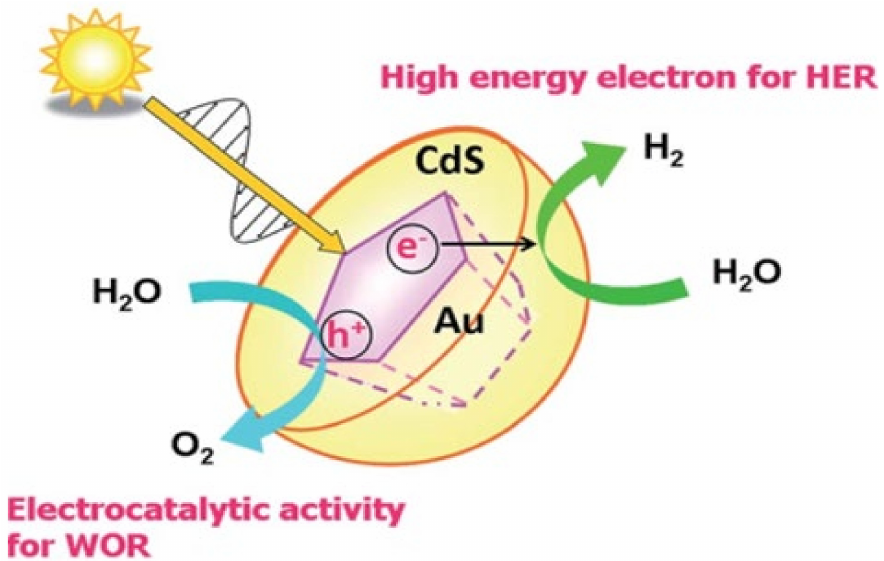
Figure 57. Schematic representation of water splitting by the HCAu@#CdS/TiO 2 plasmonic photo- catalyst. Reproduced with permission from Nano scale Adv. [455], Copyright 2019,